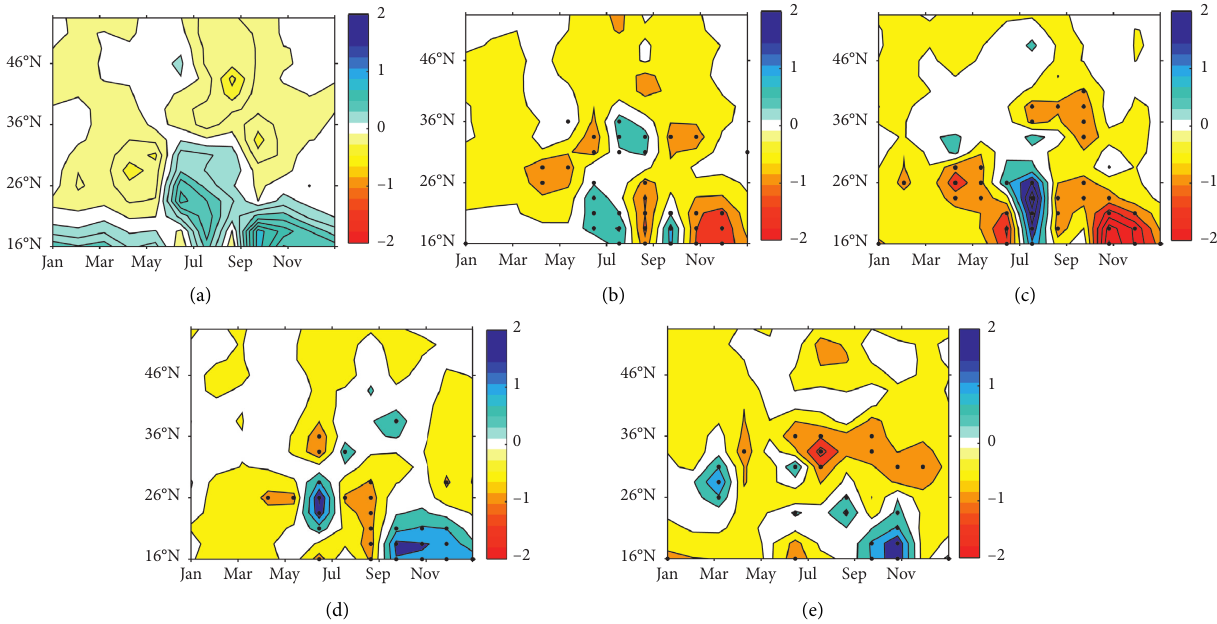
Figure 2: Temporal evolution of composite zonal mean (east of 110 ° E) precipitation in (a) climate mean and four cases: (b) developing-cool PDO, (c) developing-warm PDO, (d) decaying-cool PDO, and (e) decaying-warm PDO. Signals above the 95% confidence level are highlighted by black dots.